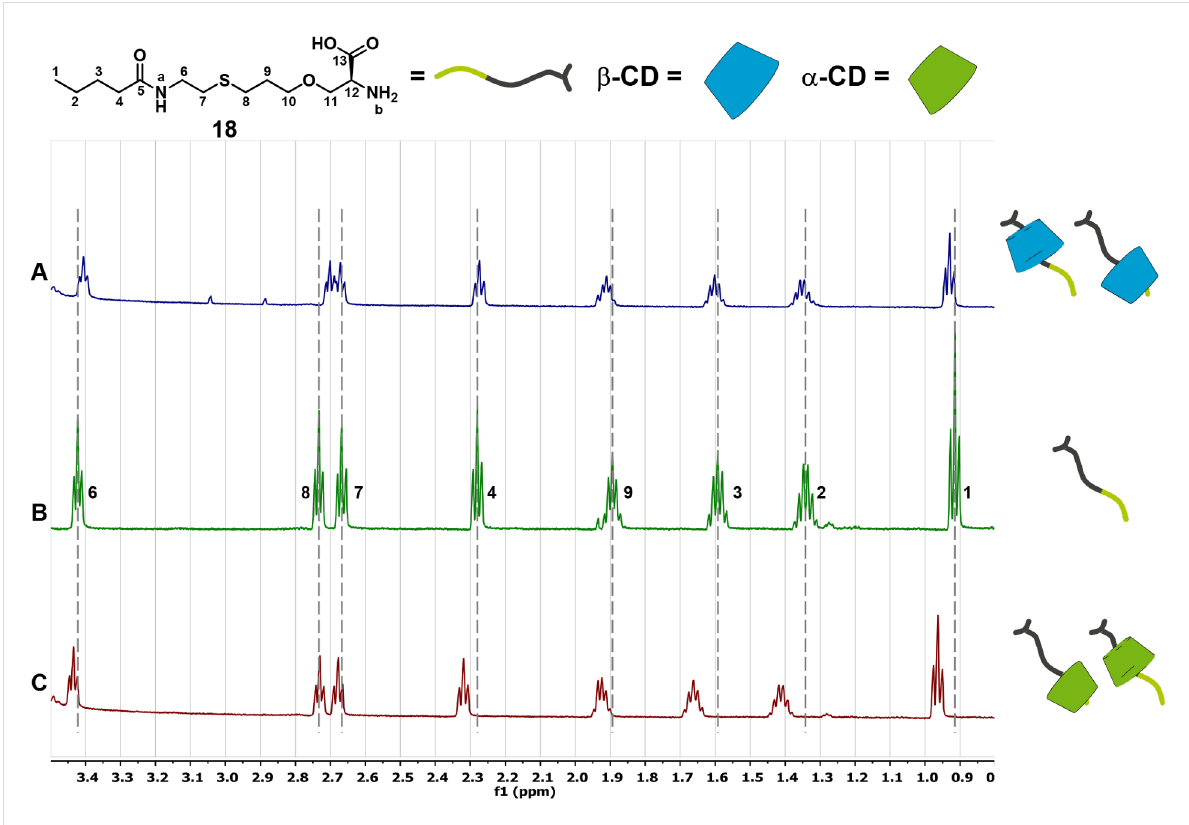
Figure 6: 1 H NMR spectra of 18 (B) and its inclusion complexes with β - (A) and α -CD (C), measured in D 2 O (600 MHz, 25 °C). A) [18] = 1.0 mM, [ β -CD] = 10 mM. B) [18] = 1.0 mM. C) [18] = 1.0 mM, [ α -CD] = 10 mM.